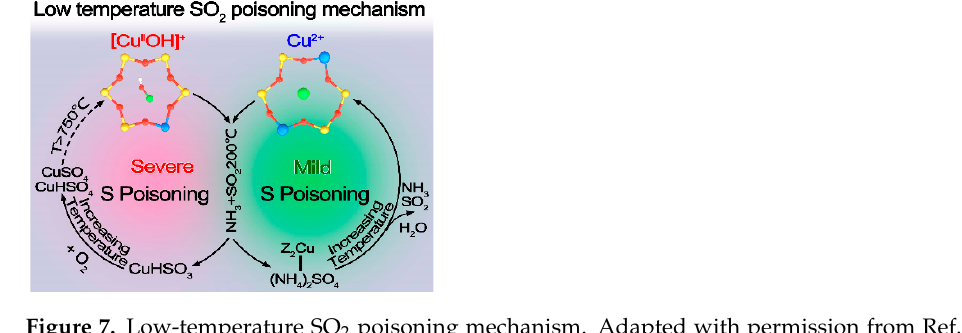
Figure 7. Low-temperature SO 2 poisoning mechanism. Adapted with permission from Ref. [33].